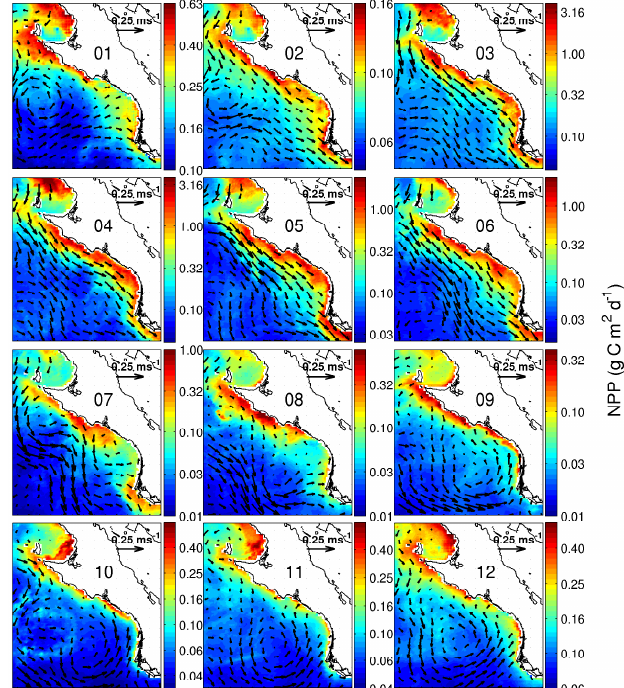
Fig. 5. Maps of monthly net primary productivity (NPP in logarith- mic scale, different for each month) and geostrophic currents for 2003–2007. Numbers in each panel indicate the month of the